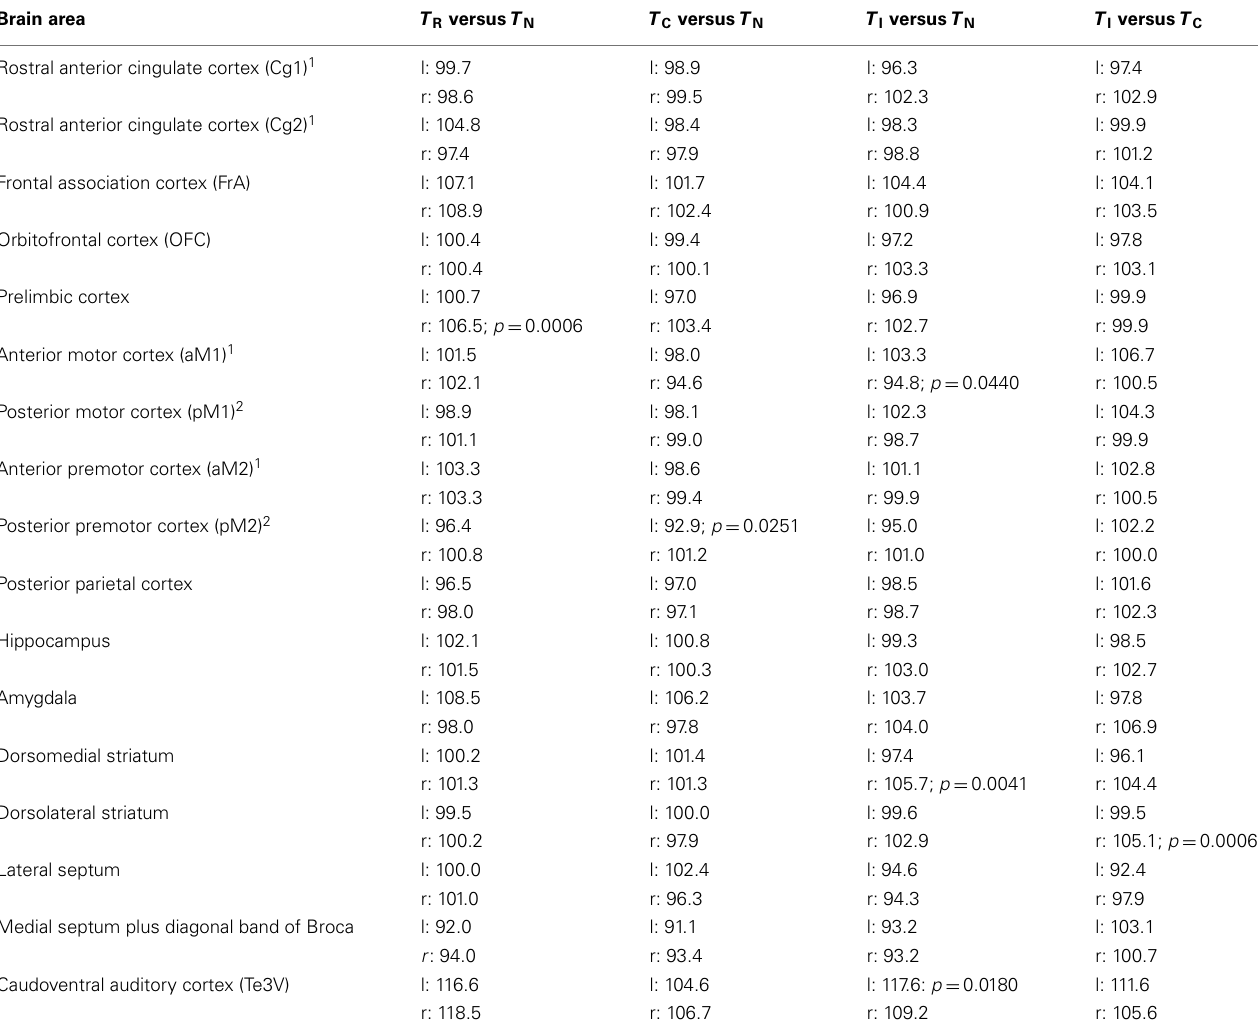
Medial septum plus diagonal band of